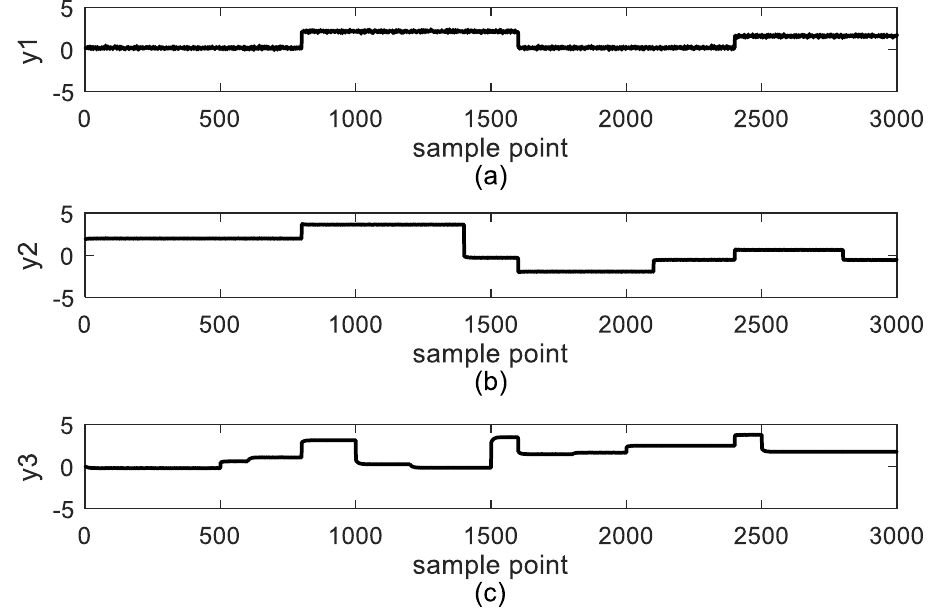
Figure 10. Output data set for polyethylene reaction: ( a ) y 1 —production; ( b ) y 2 —slurry polymer; ( c ) y 3 —catalyst